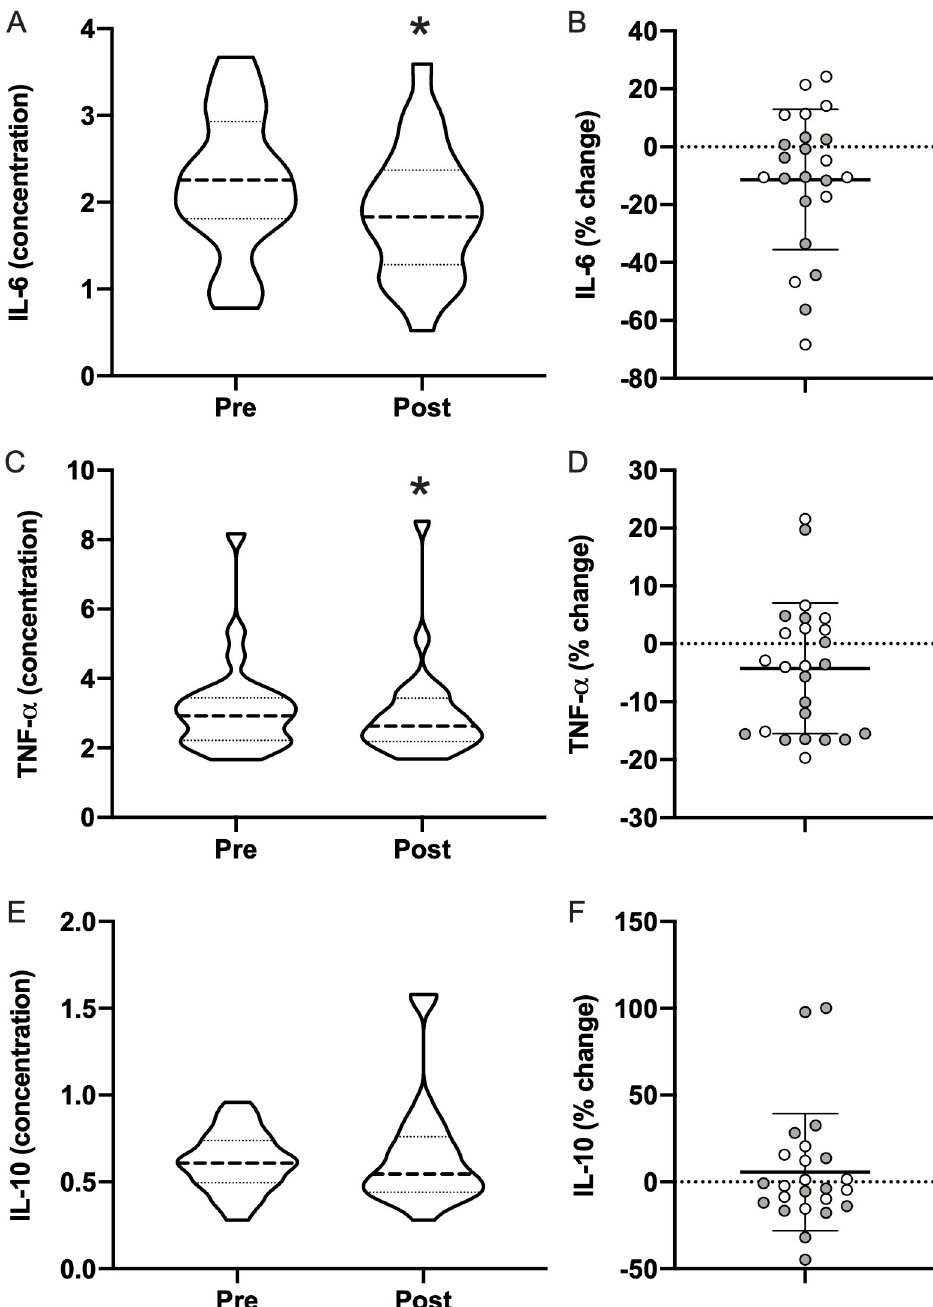
Fig 8. Peripheral cytokines. Pre- and post-morning bright light therapy biomarkers for ( A ) Interleukin-6 (IL-6), ( C ) Tumor Necrosis Factor Alpha (TNF- ɑ ), and ( E ) Interleukin-10 (IL-10) displayed as truncated violin plots with moderate smoothing (dashed line = median score; dotted lines = 25% and 75% quartiles). Percent change in each Individual for ( B ) IL-6, ( D ) TNF- ɑ , and ( F ) IL-10, plotted with the mean and standard deviation overlaid. Shaded symbols are subjects with co-morbid post-traumatic stress disorder (PTSD), open symbols are subjects without co- morbid PTSD. � = p < 0.05 vs pre; paired two-tail t-test.